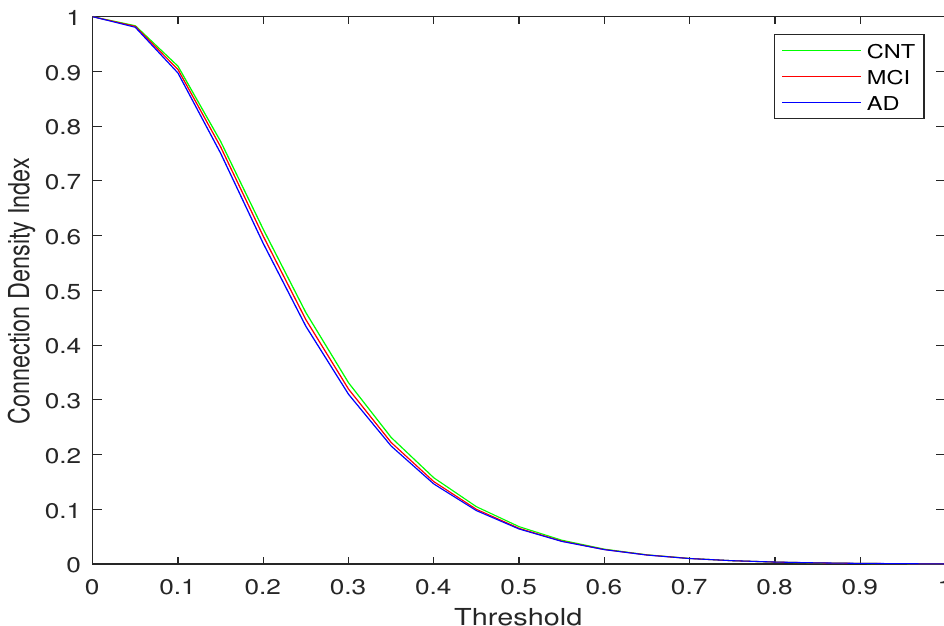
Figure 4. Mean values of the Connection Density Index ( D ) computed by thresholding the connection matrices of CNT, MCI, and